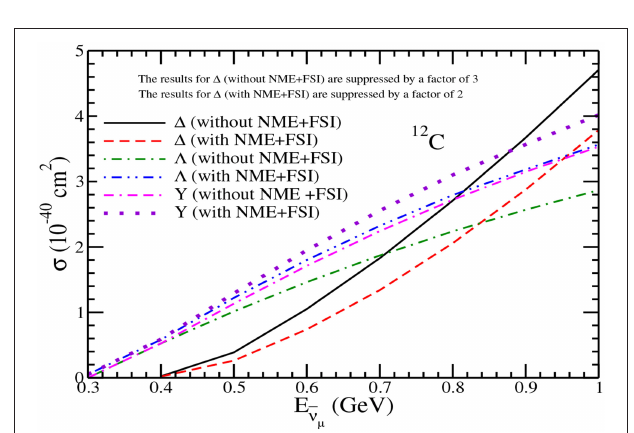
FIGURE 17 | Results for π o production in 16 O. Lines and points have the same meaning as in Figure 16 . Notice that the results of 1 without NME+FSI are suppressed by a factor of 3 and the results with NME+FSI are suppressed by a factor of 1.5.